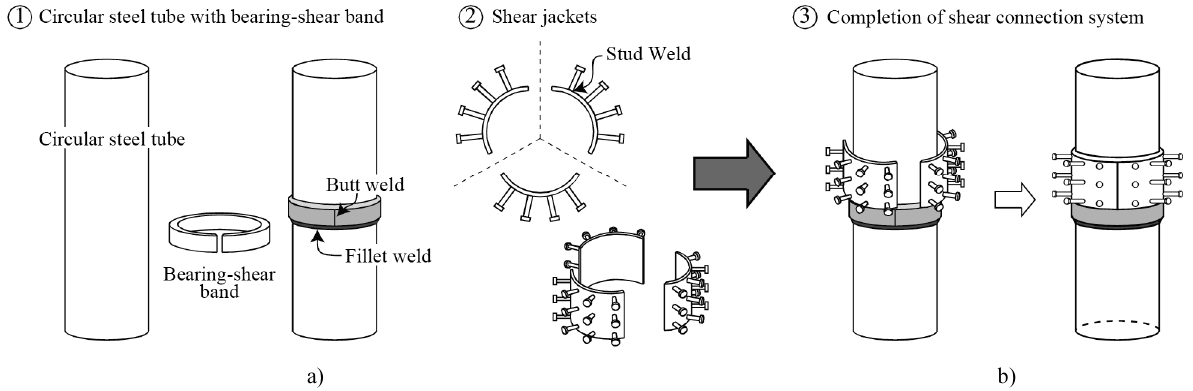
Fig. 3. Concept of the new shear connecting system: (a) application in a workshop and (b) in the field